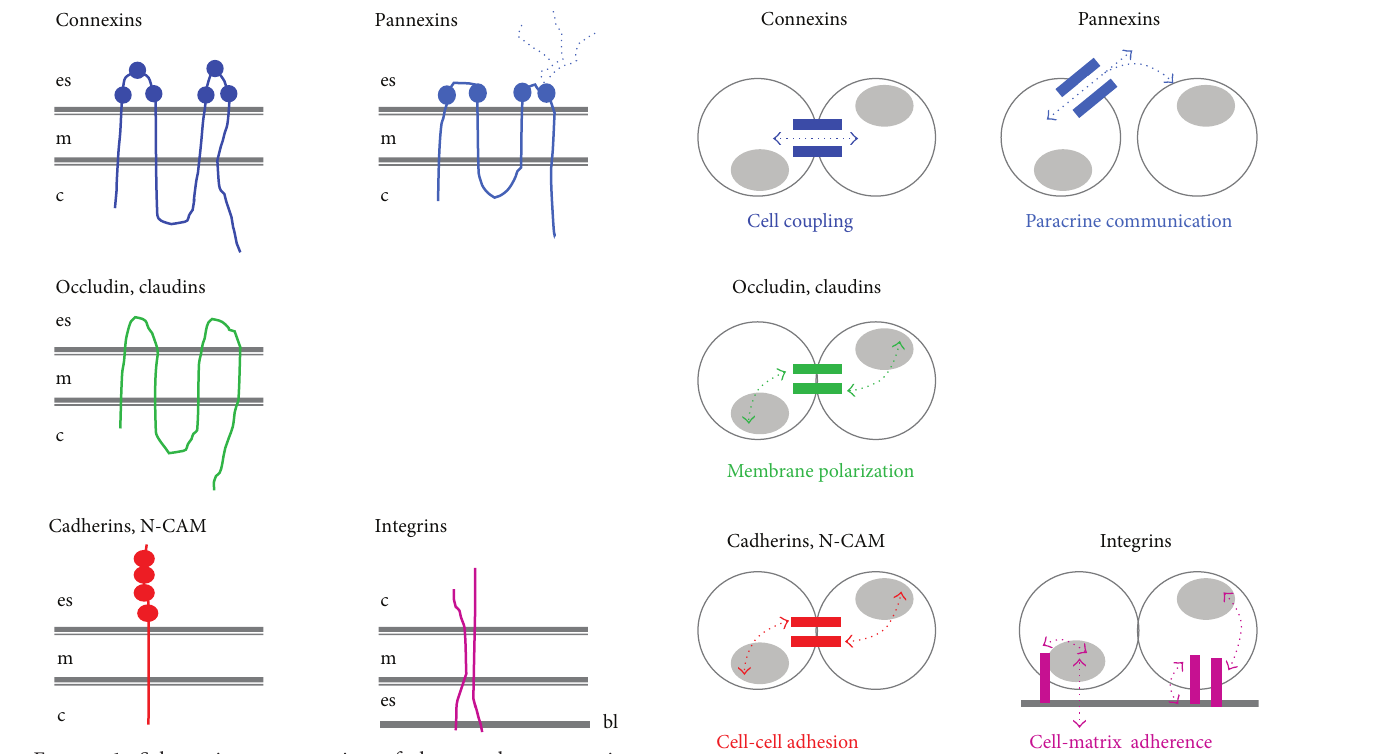
F 1: Schematic representation of the membrane proteins involved in -cell communication. Pancreatic islet cells express molecules for cell-to-cell communication, including tetraspan con- nexins, pannexins, occludins, and claudins, and single span cad- 𝛽𝛽 herins, and N-CAM. Pancreatic islet cells also express molecules for cell-to-extracellular matrix communication, notably integrins. e spherical symbols on the extracellular loops of connexins and pannexins indicate the presence of highly conserved cysteine residues. e branched, dotted line on the second loop of pannexins indicates the site of glycosylation.